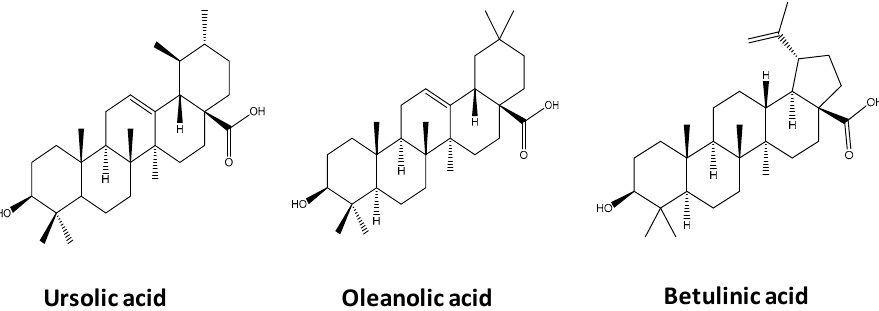
Figure 1. Chemical structure of the three main triterpenic acids present in Eucalyptus species outer bark.